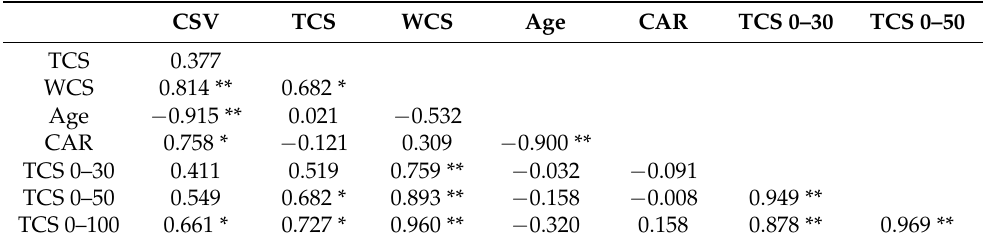
Table 4. Pearson correlation analysis of the Pakua tableland data. CSV TCS WCS Age CAR TCS 0–30 TCS 0–50 TCS 0.377 WCS 0.814 ** 0.682 * CAR